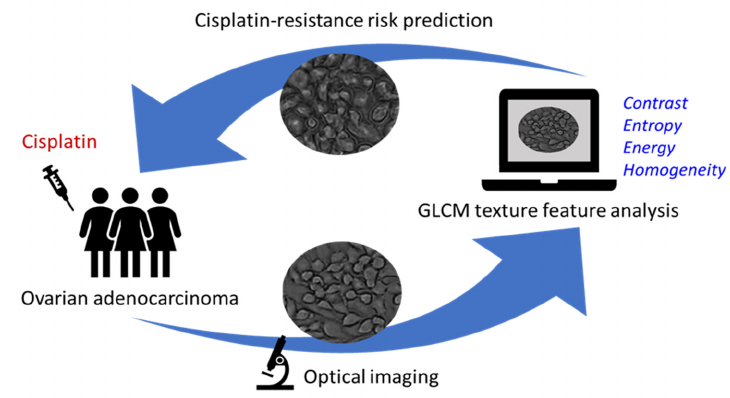
Figure 4. Sketch of the proposed promising model to achieve a rapid method with a more reliable diagnostic performance for identification of ovarian adenocarcinoma cells with cisplatin-resistance by feature extraction of GLCM in vitro or ex vivo.